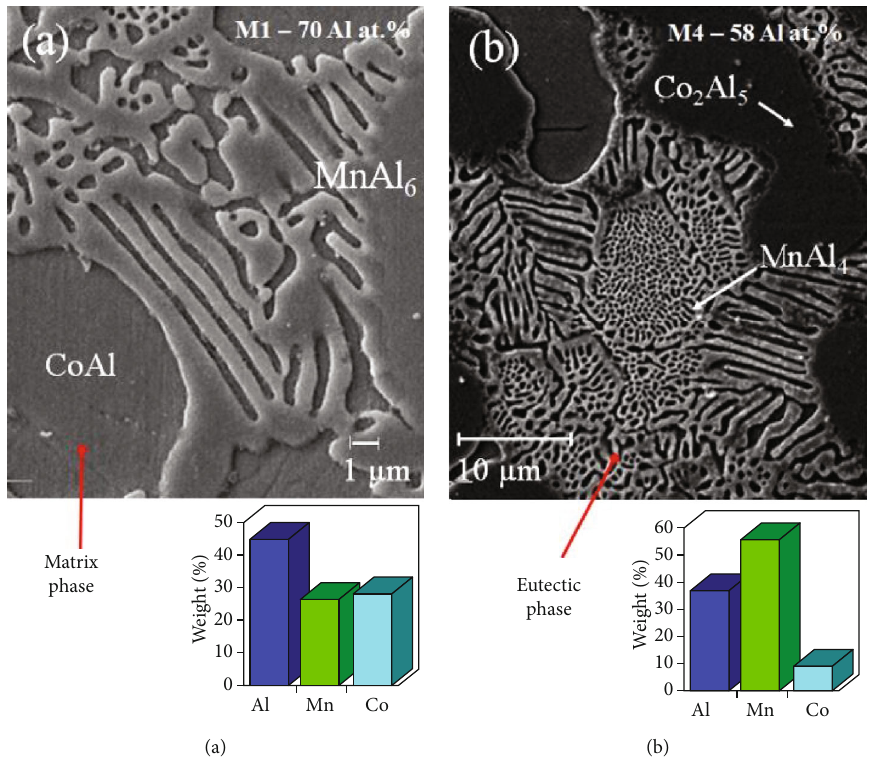
Figure 12: SEM and EDS analysis in the matrix and second phase for the M1 and M4 samples as cast.